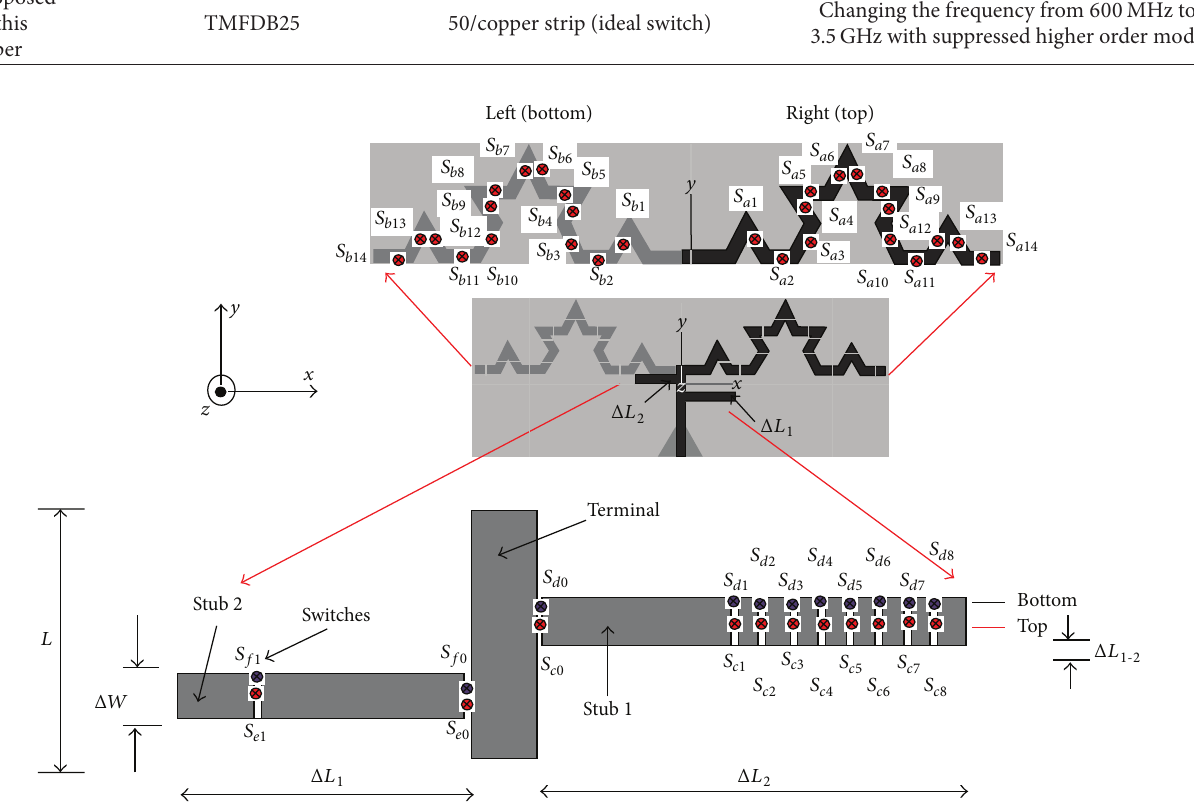
Figure 1: TMFDB25 antenna